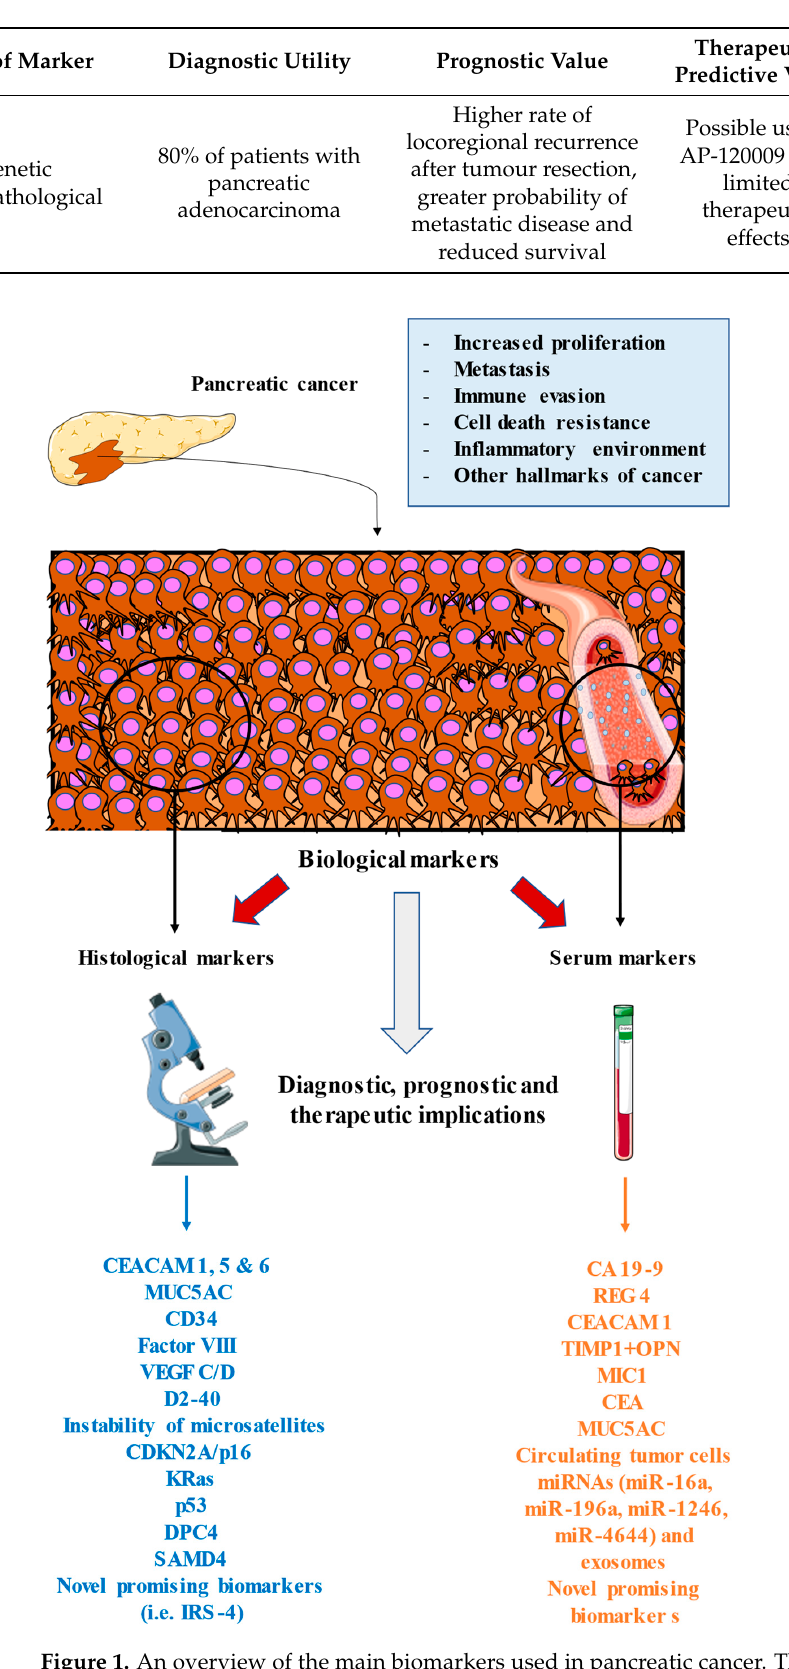
Figure 1. An overview of the main biomarkers used in pancreatic cancer. These markers are found in the proper tumour environment, as studied by histological techniques or released in blood or lymphatic vessels, which may be studied in the form of serological analysis. All of these markers are involved or related to the different oncogenic processes that occur in the tumour, including en- hanced proliferation, immune and cell death evasion, the inflammatory environment, metastasis, and other hallmarks of cancer. The study and inclusion of these markers in clinical practice may greatly aid the clinical management of patients with pancreatic cancer, including at the diagnostic, prognostic, and therapeutic (predictive) levels.